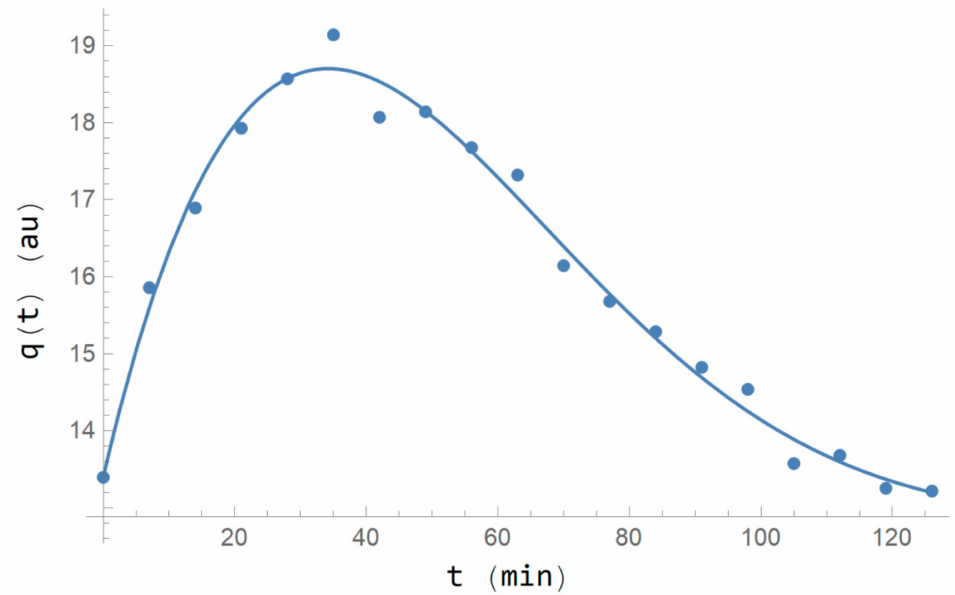
Figure 2. Evolution of the GFP or q ( t ) for the 28 individuals mean scores (dots) and the calibrated curve (line), in the period of the experiment (126 min).